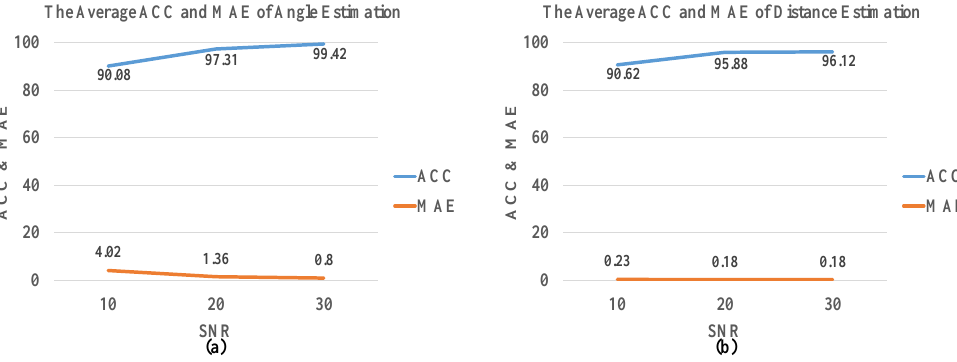
Figure 7. The average accuracy and MAE of ( a ) angle and ( b ) distance estimation by CNN-R in a single acoustic environment, where SNR = 10 dB, 20 dB, 30 dB, and RT60 = 0.16 s.